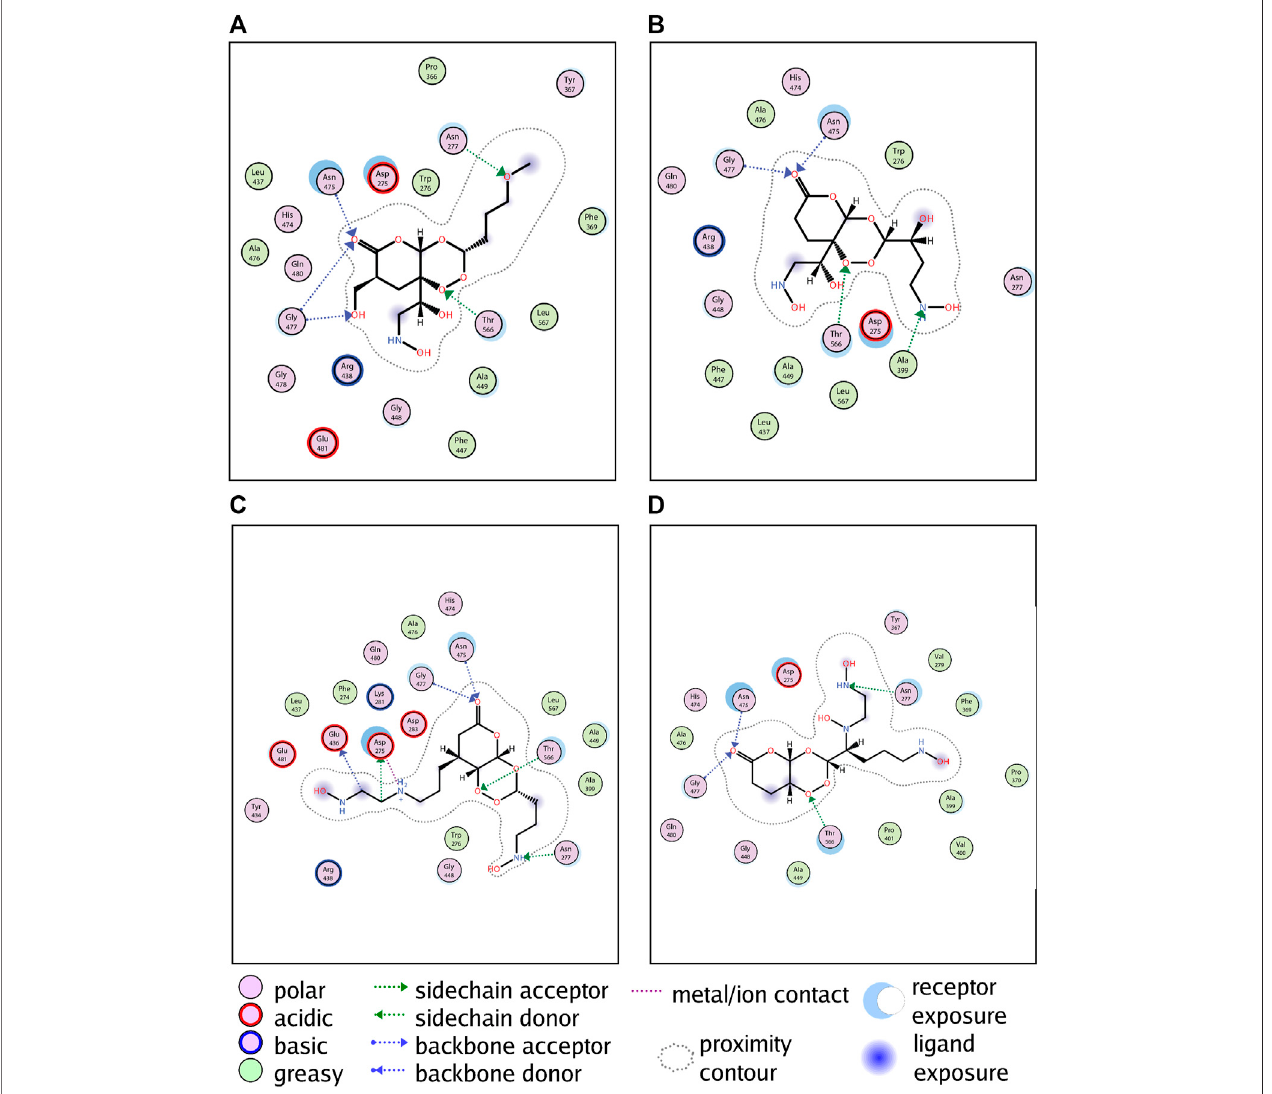
FIGURE 5 | Molecular docking simulation of candidate compounds with kernel targets. From (A – D) are the docking patterns of L379, L528, L941 and L961, respectively.